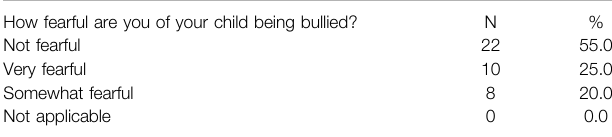
TABLE 2 | How fearful are you of your child being bullied? How fearful are you of your child being